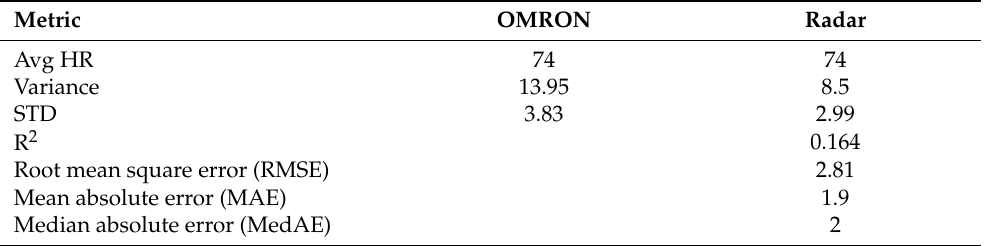
Table 3. Evaluation metrics to compare cuff-based and radar-based HR